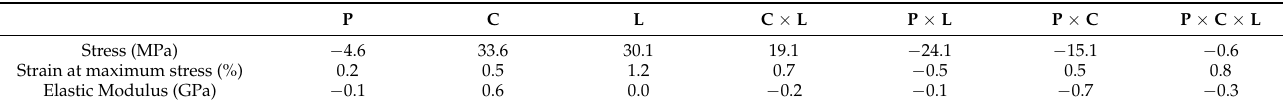
Table 8. Factors and their interactions after applying Yates’